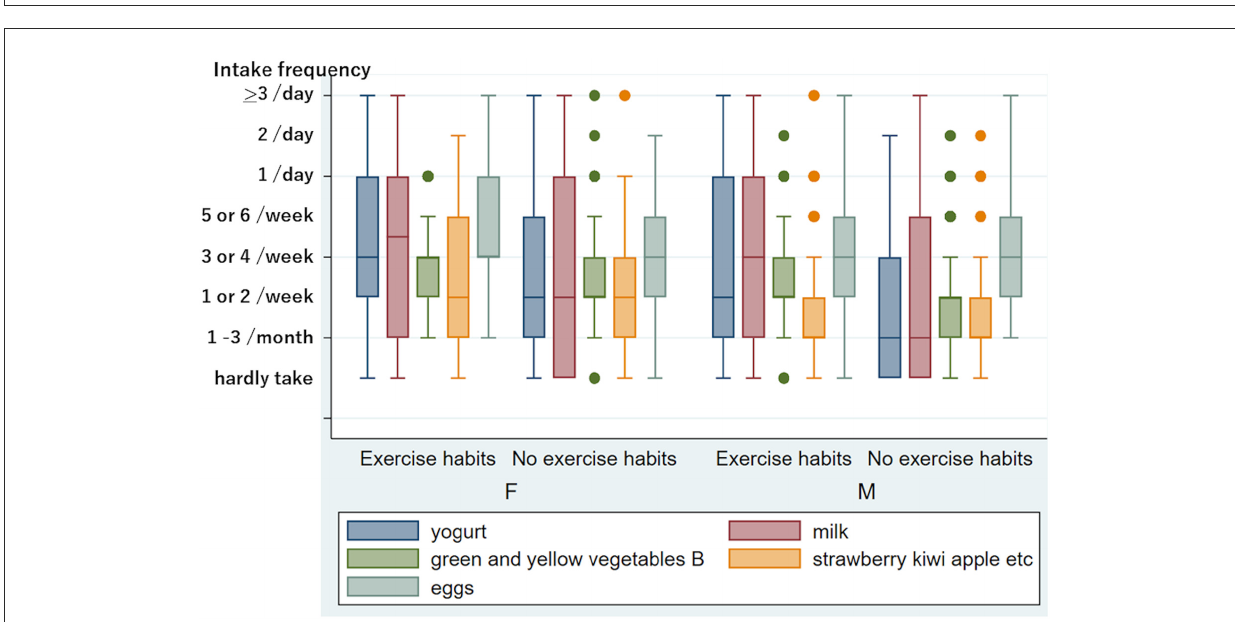
FIGURE2 Frequency of eating and drinking in people with and without exercise habits in women and men. Five kinds of food and drink with a significant difference between persons with and without exercise habits after adjusting for age in women and/or men. The y-axis is the same as in Figure 1. The number of people belonging to outliers is as follows: In 102 women with exercise habits, green and yellow vegetables B “1/day”: five. In 192 women without exercise habits, green and yellow vegetables B “hardly take”: three, “1/day”: 13, “2/day”: one, “ > 3/day”: one; strawberry, kiwi, apple, etc. “ > 3/day”: one. In 102 males with exercise habits, green and yellow vegetables B “hardly take”: two, “1/day”: four, “2/day”: one; strawberries, kiwis, apples, etc. “5 or 6/week”: five, “1/day”: five, “ > 3/day”: one. In 113 men without exercise habits, green and yellow vegetables B “5 or 6/week”: six, “1/day”: two, “2/day”: one; strawberries, kiwis, apples, etc. “5 or 6/week”: two, “1/day”: six, “2/day”: